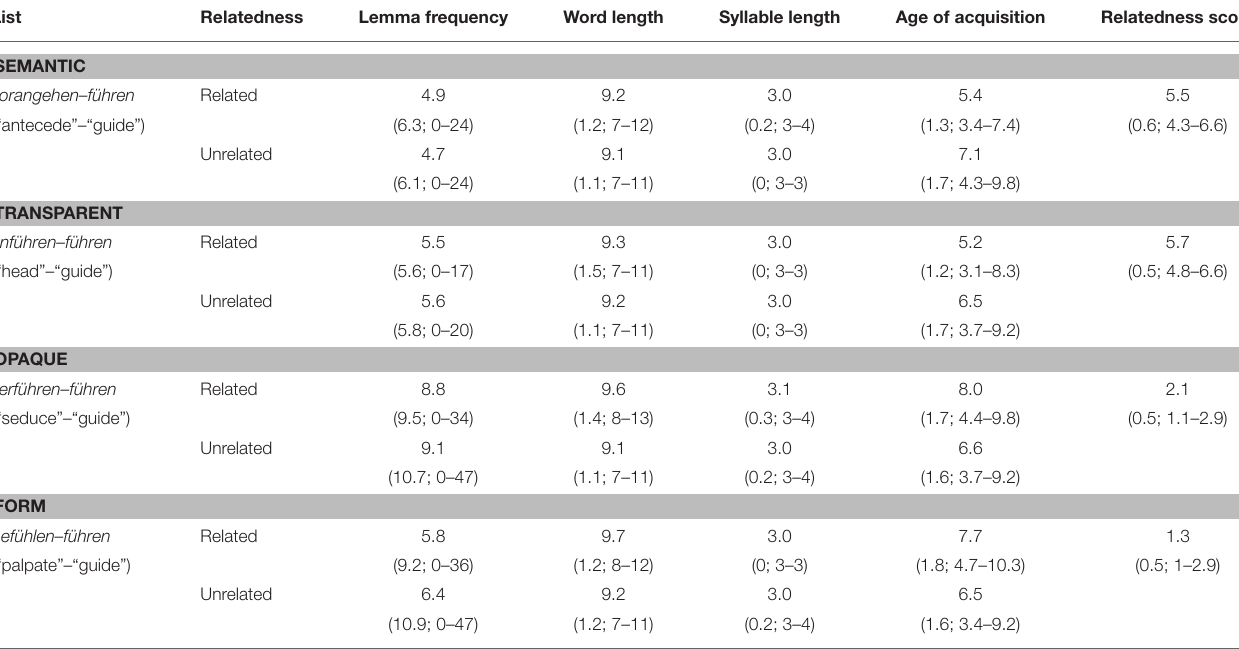
TABLE 1 | Stimulus characteristics of related primes and their matched unrelated controls in the semantic synonym list, semantically transparent list, semantically opaque list, and form control